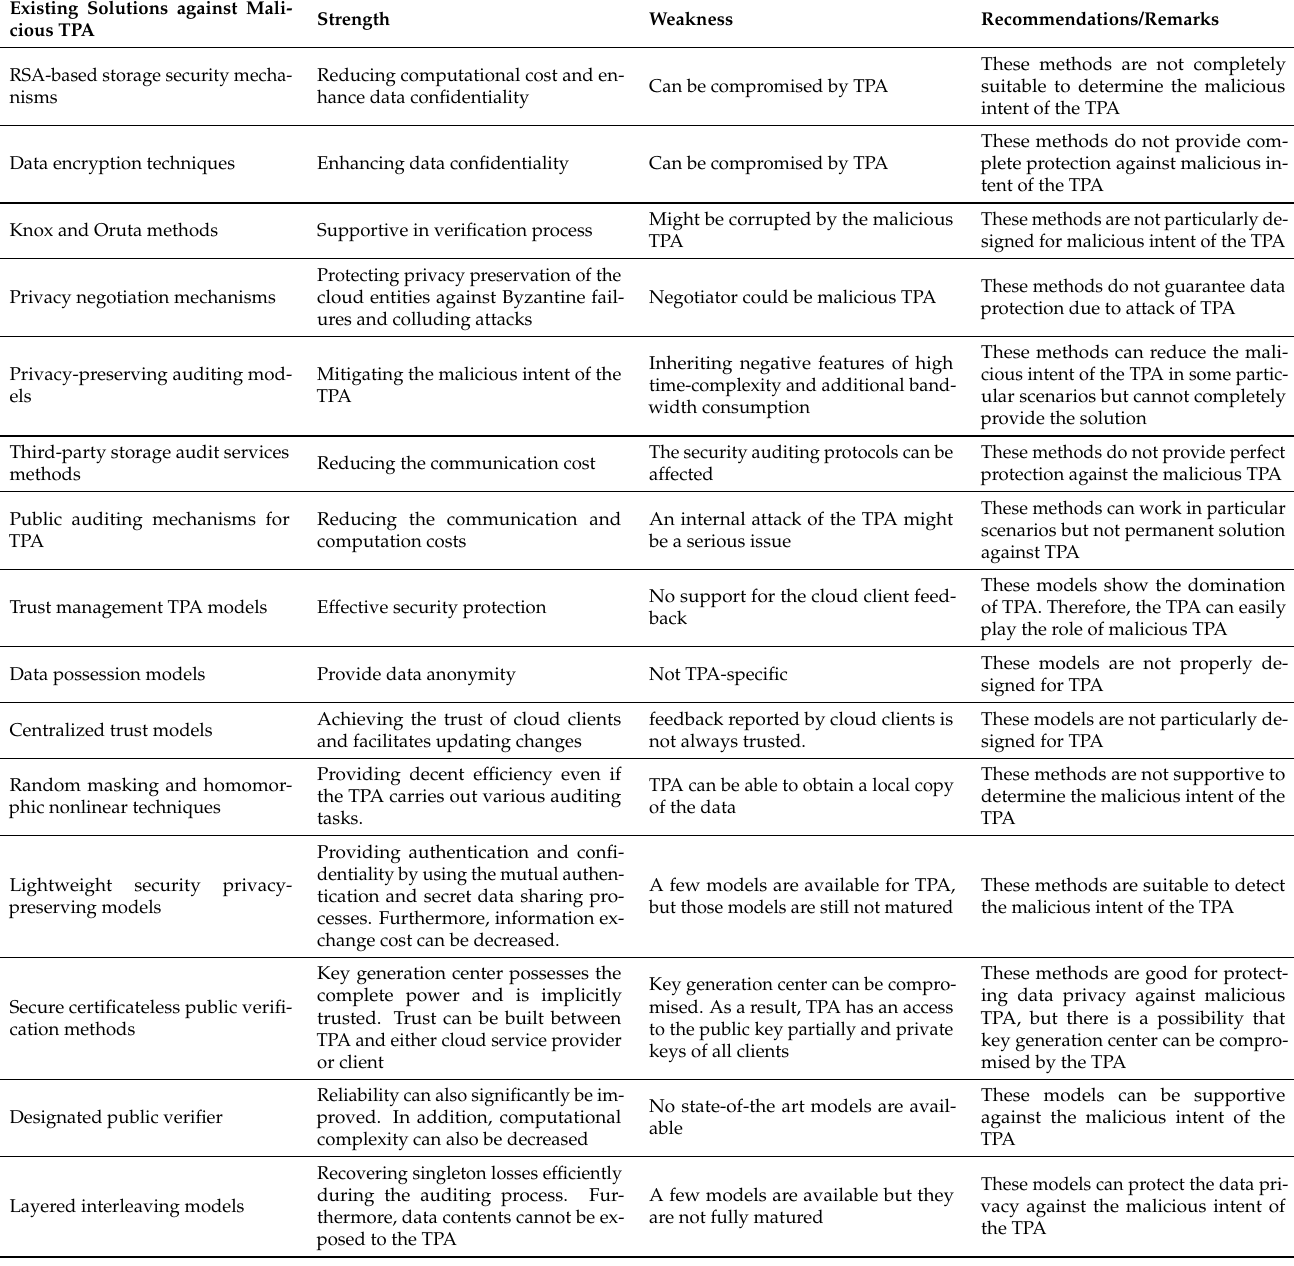
Table 4. Strengths and weaknesses of the existing solutions proposed for the malicious intent detection of the TPA and recommendations for choosing better